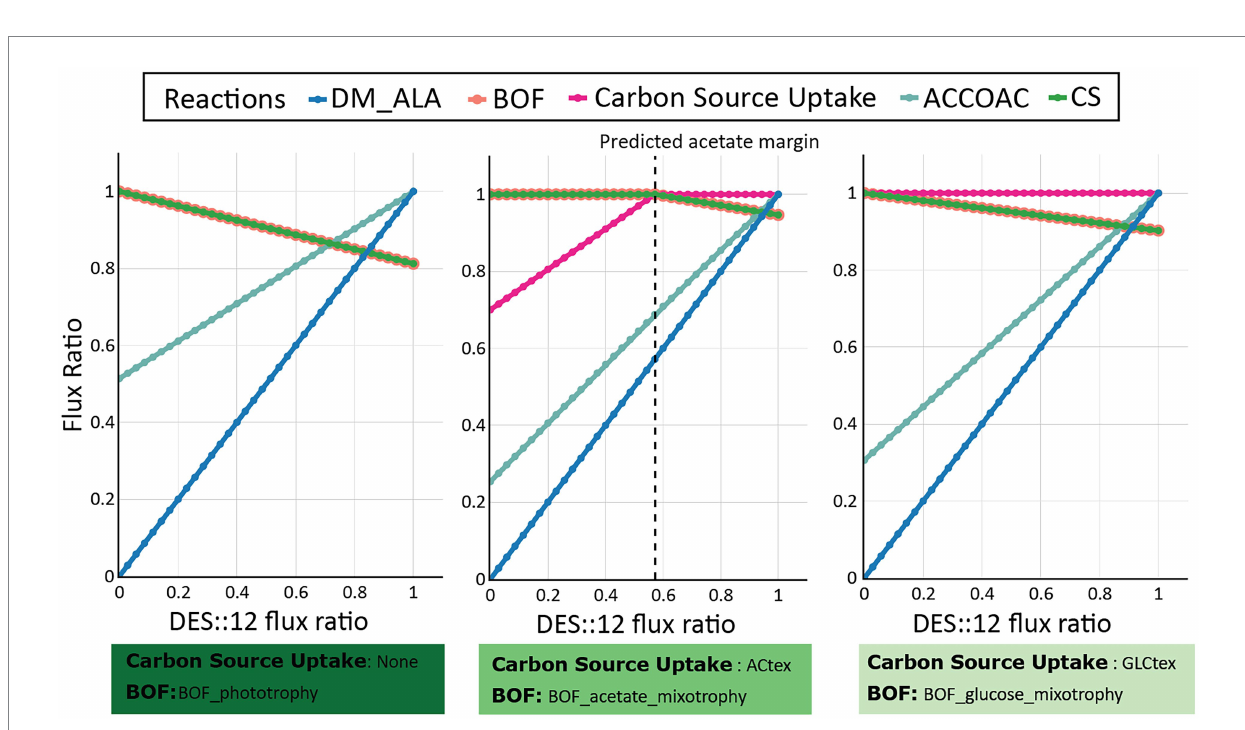
FIGURE 8 Flux variability analysis of Δ 12-desaturase (DES::12) overexpression in different nutritional conditions. Impact of DES::12 overexpression on growth rate (BOF), ALA production (DM_ALA), and organic carbon uptake (Carbon Source Uptake) under photoautotrophic (left panel), photomixotrophic with acetate (middle panel), and photomixotrophic with glucose (right panel) conditions. Fluxes through some reactions of the fatty acid synthesis (ACCOAC) and TCA cycle (CS) were